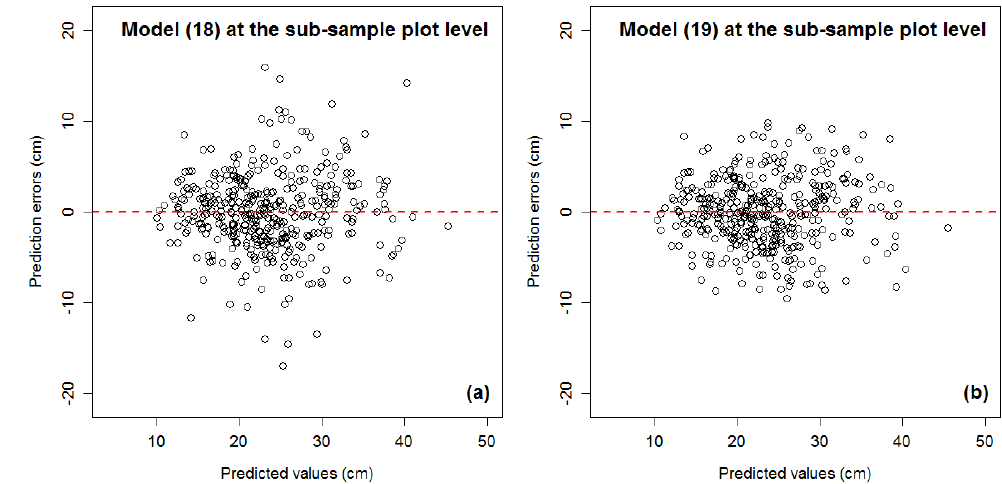
Figure 5. Prediction errors based on Equation (18) with a variance-stabilizing function excluded ( a ) and prediction errors based on Equation (19) ( b ) with a variance-stabilizing function included